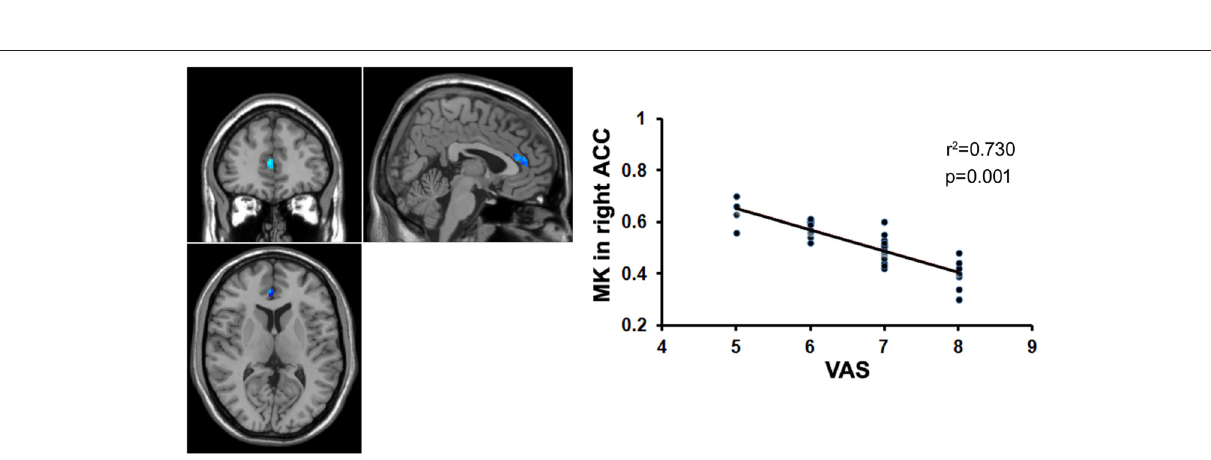
FIGURE 6 | Correlation analysis between the MK value and the VAS score. There was significant negative correlation between the MK value in the right ACC and the VAS score in patients with chronic myofascial pain.